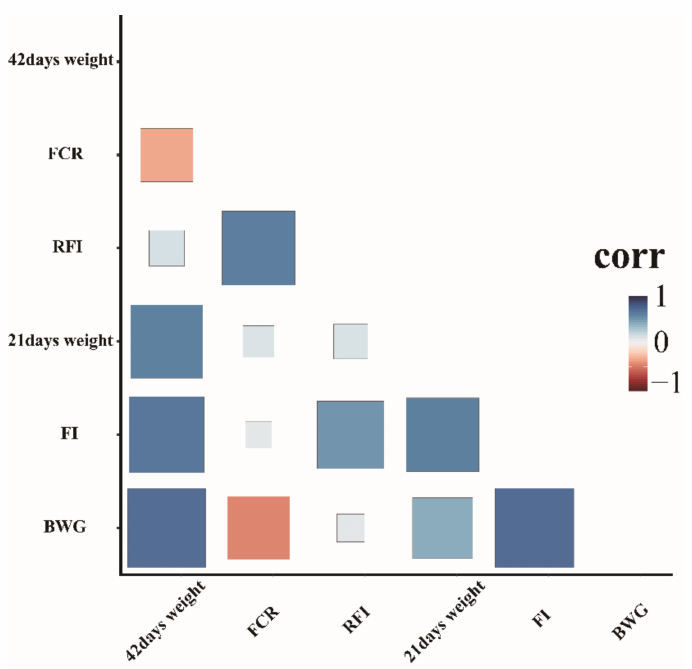
Figure 1. Pairwise Pearson correlation coefficients for the different FE traits analyzed.